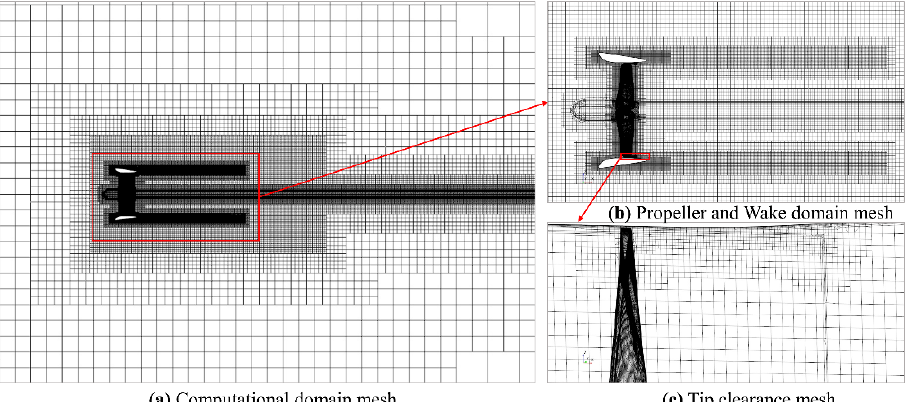
Figure 5. Side mesh view of the entire calculation.